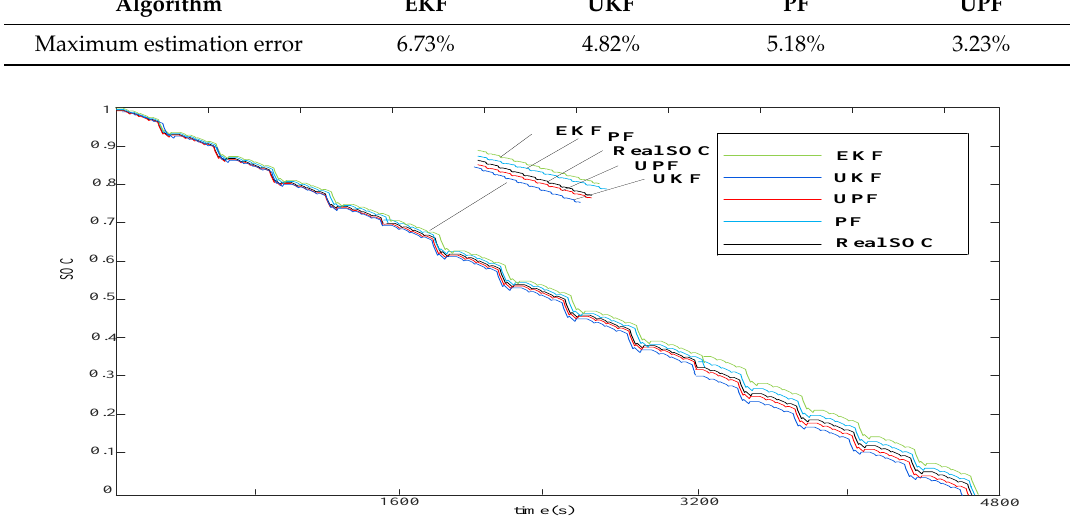
Figure 21. SOC Estimation curves of different methods.